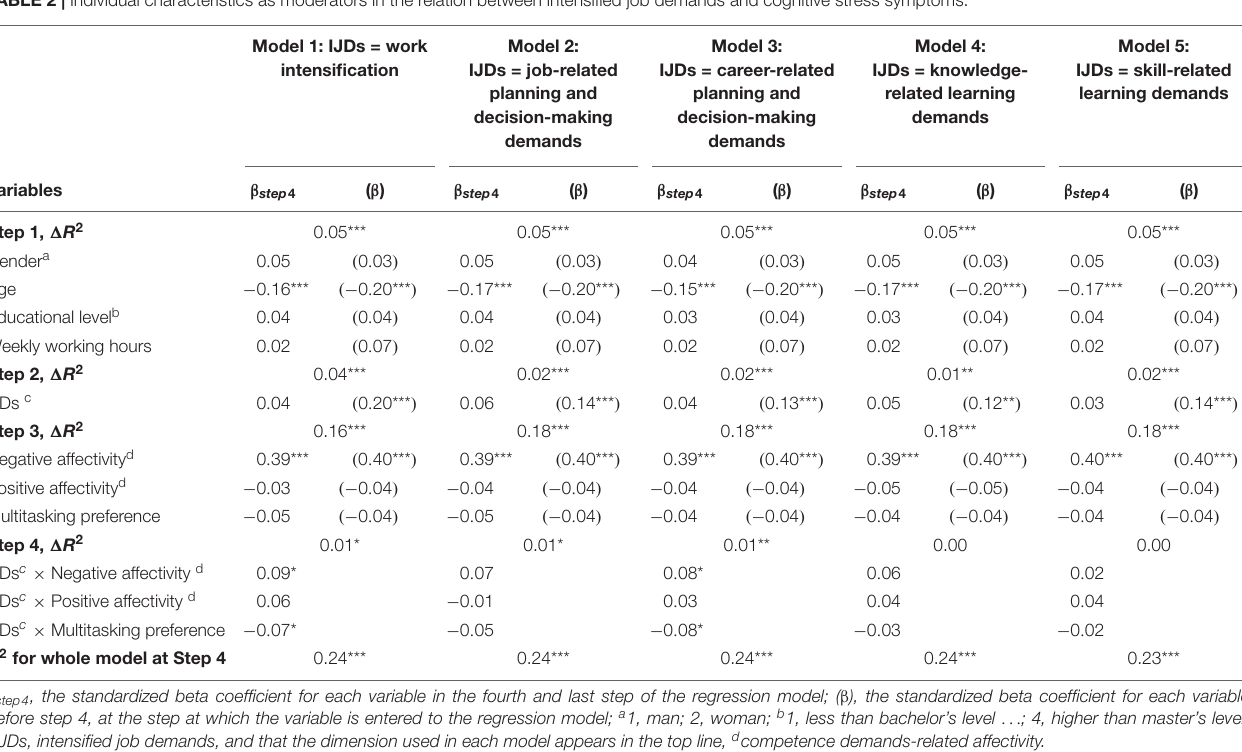
TABLE 2 | Individual characteristics as moderators in the relation between intensified job demands and cognitive stress symptoms.